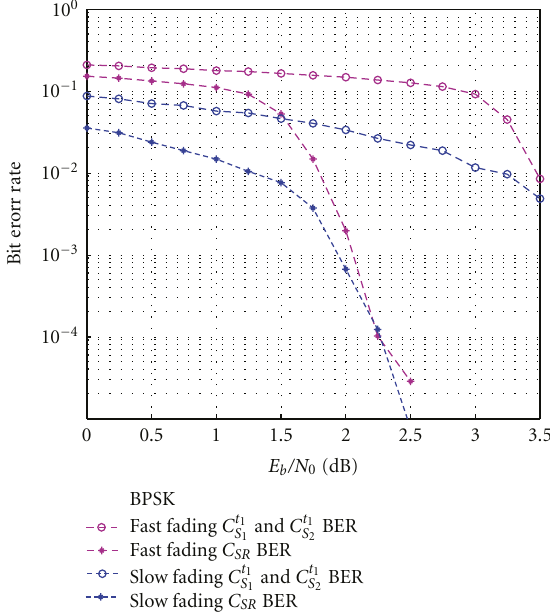
Figure 11: The BER performance under the Rayleigh Fading channel with BPSK, d = 0 . 5, and R t 1